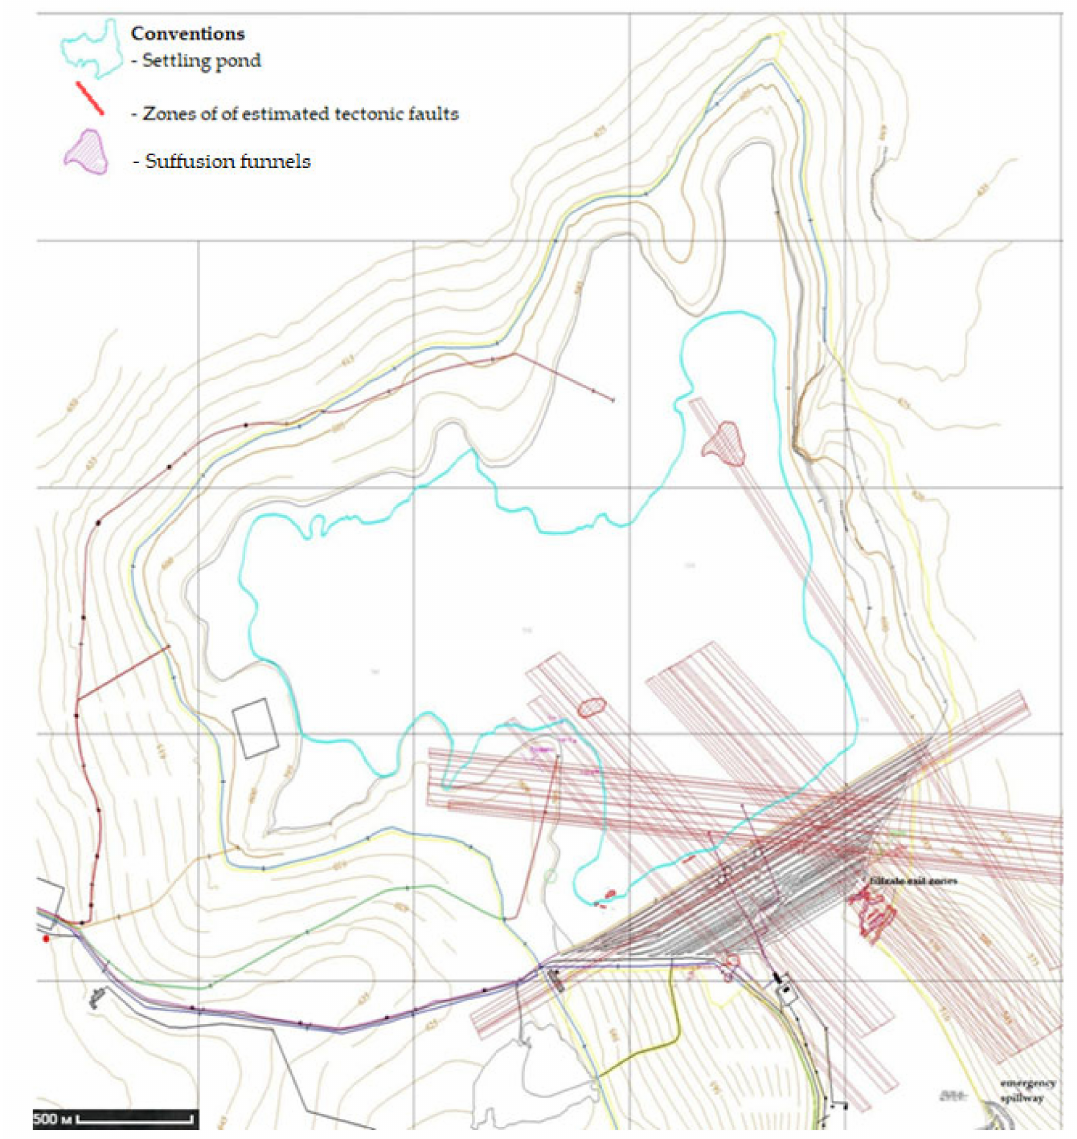
Figure 2. Scheme of estimated tectonic faults (colored thick lines—communications of the processing plant with the